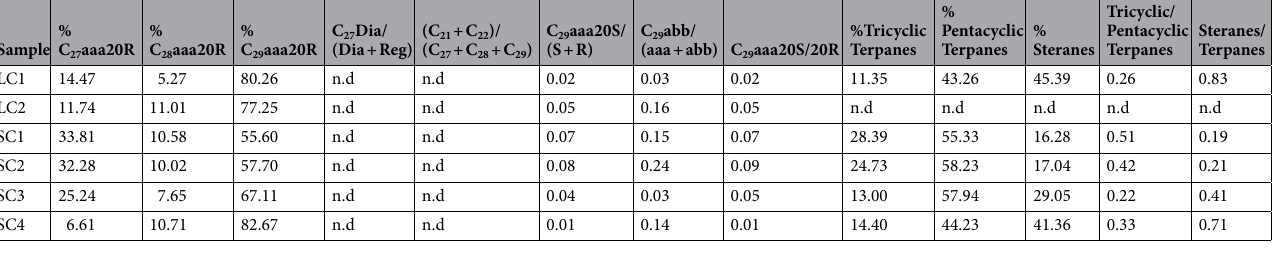
Table 4. Biomarker indicators sources and maturity of organic matter. Dia diasteranes, Reg regular steranes, n.d. not